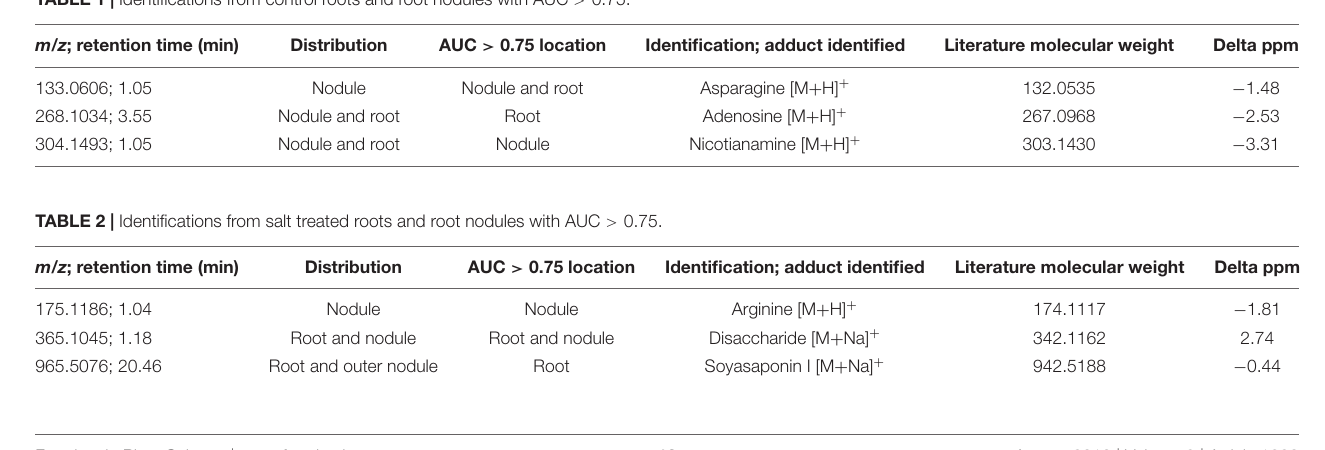
for verification of the identification. The MS/MS spectra for the standards are in Supplementary Figure 7 . Retention times